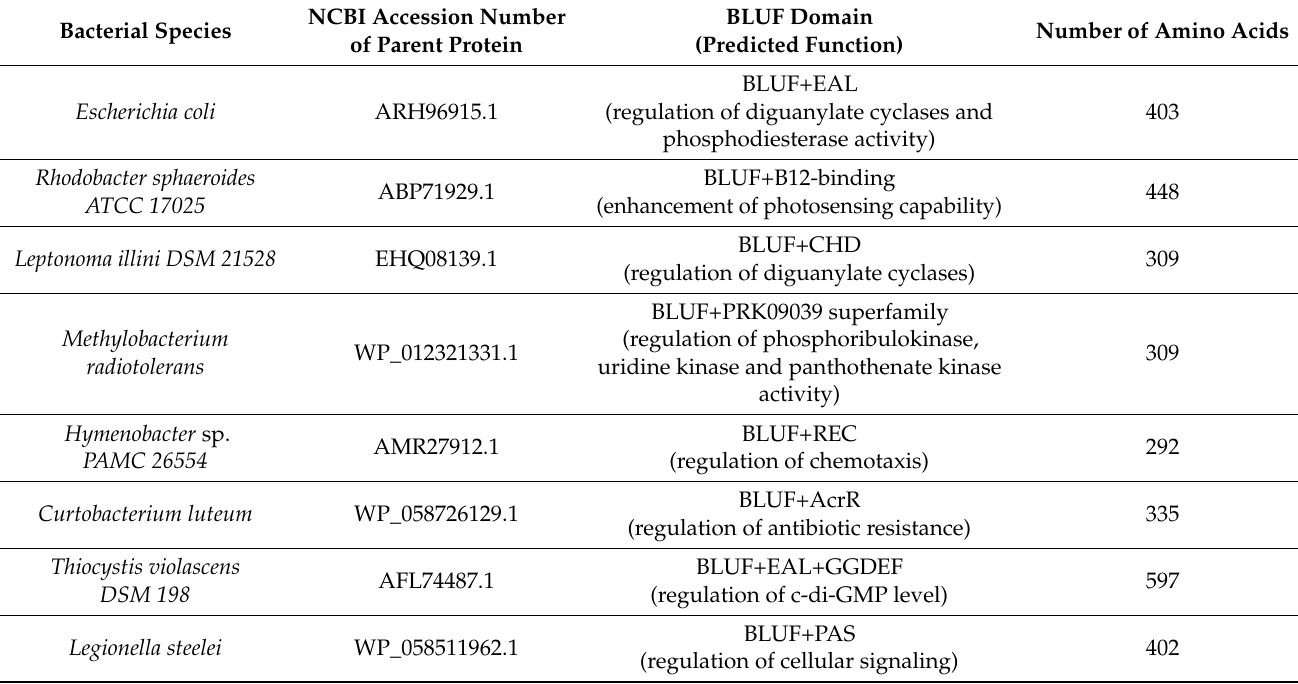
Table 4. Selected prokaryotic proteins containing different BLUF domains. Data presented were obtained from Kaushik et al. (2019), which was published under Creative Commons Attribution 4.0 International License (https://creativecommons. org/licenses/by/4.0/, accessed on 28 July 2021.)